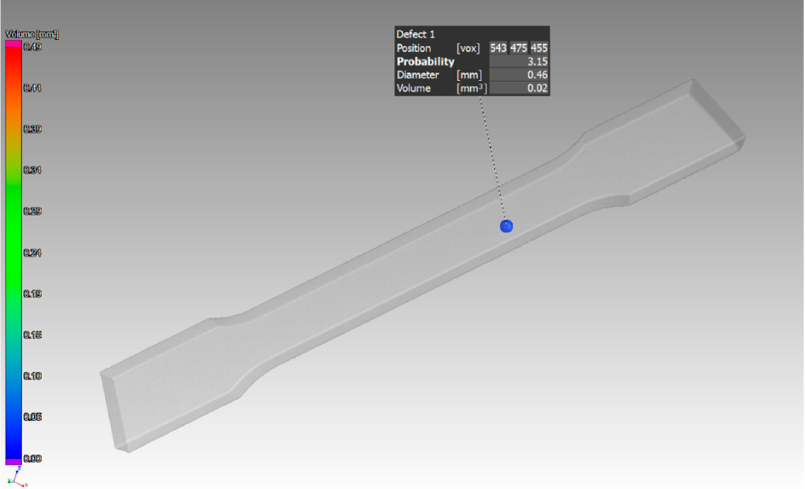
Figure 15. Specific defects in the sample with 3 mm thickness, which was oriented in Z. The identification of defects at specific locations of the sample with thickness of 3 mm, which was oriented in the XZ direction, is shown in Figure 16.